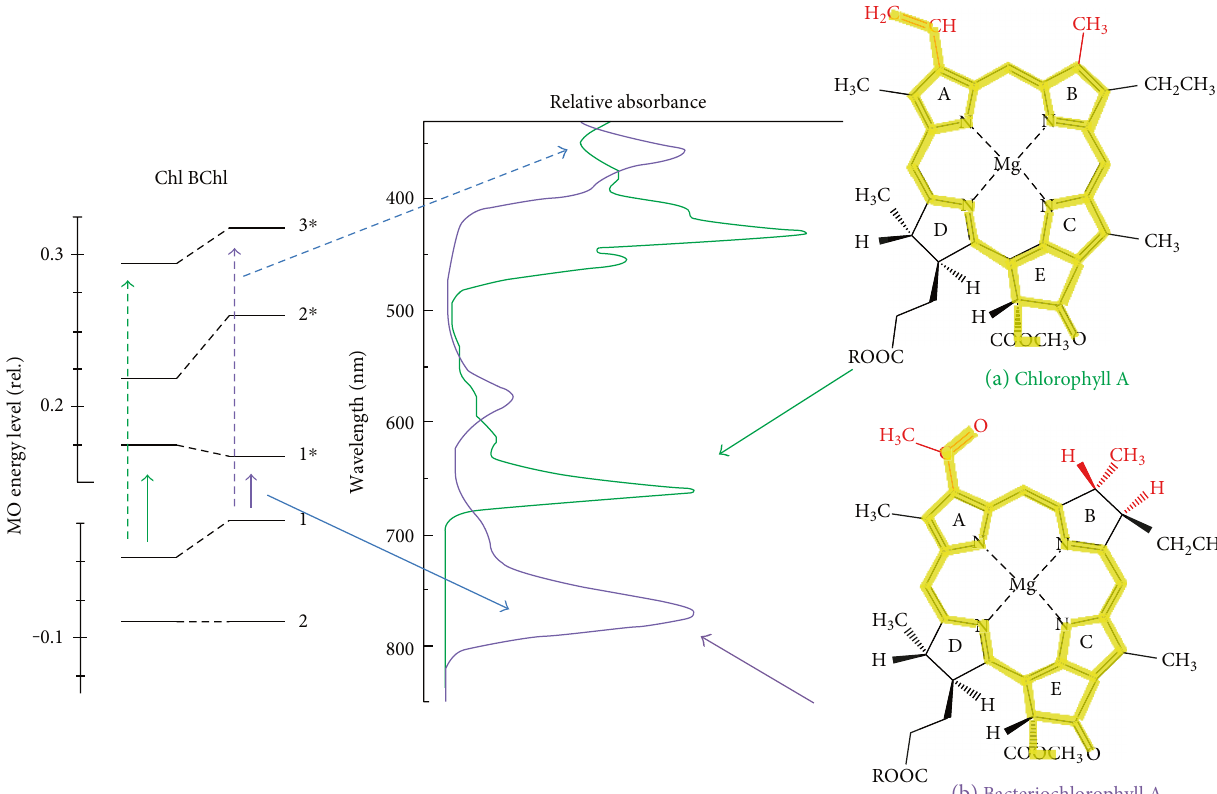
Figure 1: The connection between the molecular, energetic, and spectral characteristics of the chlorophyll and bacteriochlorophyll molecules. The molecular orbital (MO) levels of chlorophylls (Chl) and bacteriochlorophylls (BChl) (left). The S indicated by solid and dotted lines, respectively. The absorption spectra of chlorophyll-a and bacteriochlorophyll-a corresponding to the → S → S S and S transitions as indicated by the characteristic lines (middle). The molecular structures of chlorophyll-a and 0 1 0 n bacteriochlorophyll-a molecules (right). The conjugated double bond systems are